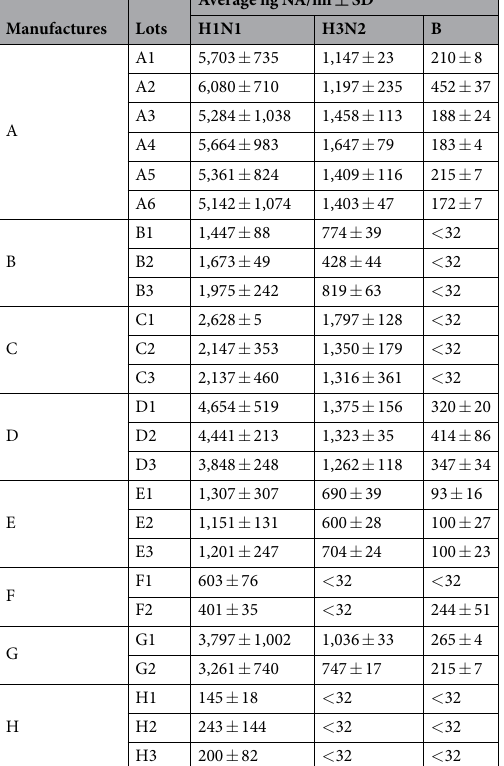
Table 2. NA contents in 2016~2017 seasonal influenza vaccines. Note: the HA antigen content of 3 subtype/ type are within 30~36 μ g/ml; each sample was tested three